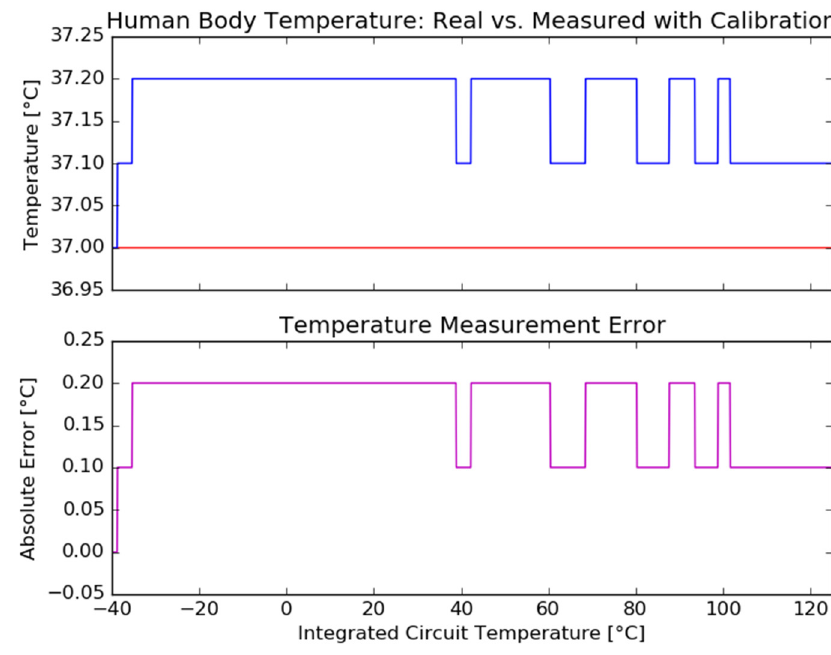
Figure 26. AFE model simulation results with temperature calibration technique.